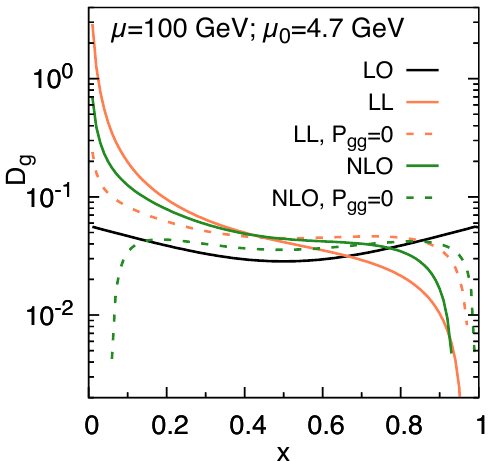
Figure 7 . The D g fragmentation function at LO (black), LL (orange) and NLO (green), for (cid:22) = 100 GeV, (cid:22) 0 = 4 : 7 GeV. Solid curves represent the complete expressions; dashed curves are obtained by setting P gg =